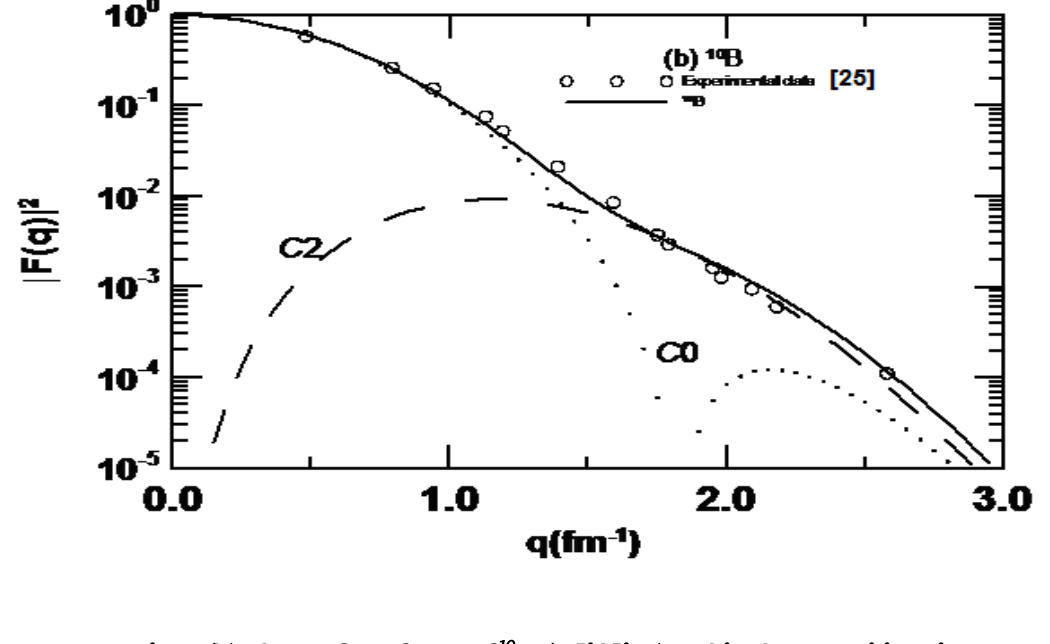
Fig.2: (b) Charge form factor of 10 B (solid line) and its decompositions into C0 (dotted line) and C2 (dashed line) contributions in comparison with the experimental data (open circles) of ref.